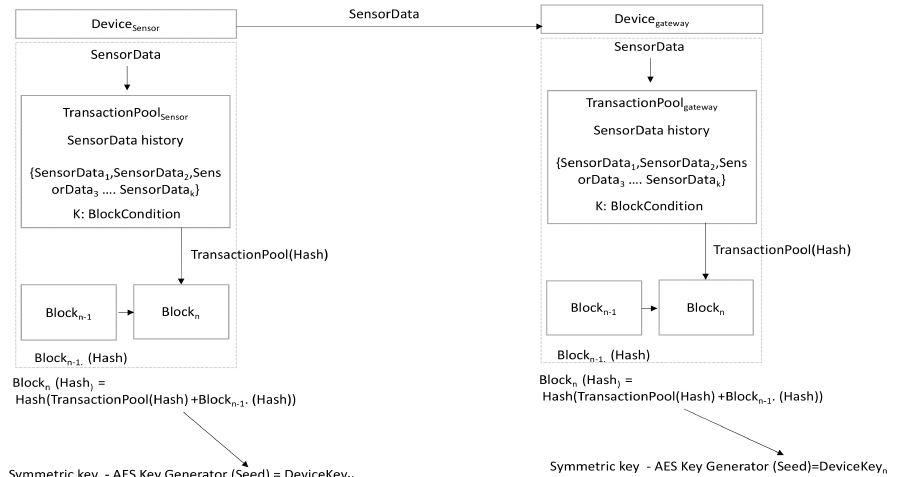
Figure 4. Concept of dynamic encryption key using block hash